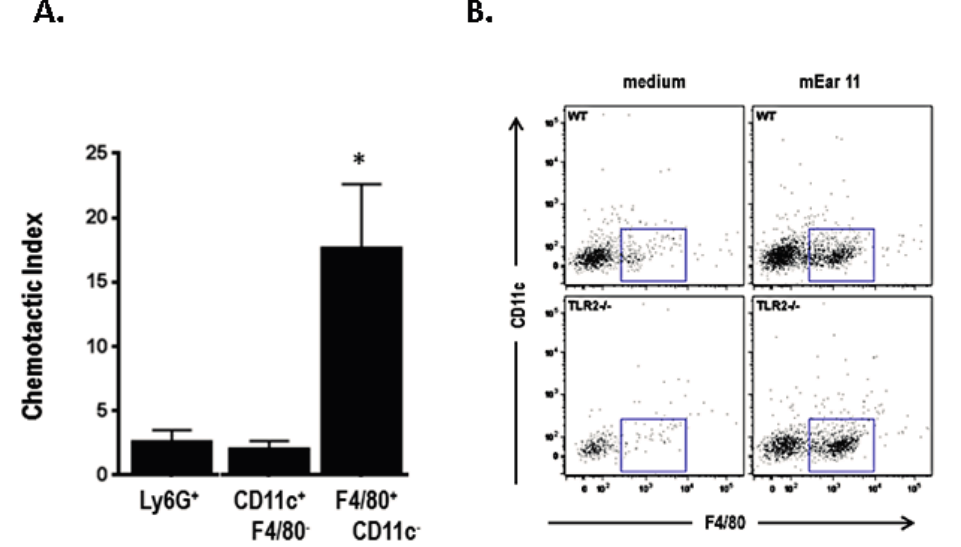
Figure 6. Recombinant P. pastoris -derived mEar 11 is chemoattractant for F4/80 + CD11c − macrophages. ( A ) Chemotactic indices calculated for leukocyte subsets, including Ly6G + (neutrophils), CD11c + F4/80 − (dendritic cells) and F4/80 + CD11c − (macrophages); * p < 0.05; ( B ) Representative flow plots documenting that F4/80 + CD11c − splenocytes (within boxes) from TLR2 − / − mice migrated in response to mEar 11 to an extent indistinguishable from those from wild-type mice. Reprinted from [73] with permission from American Society for Biochemistry and Molecular